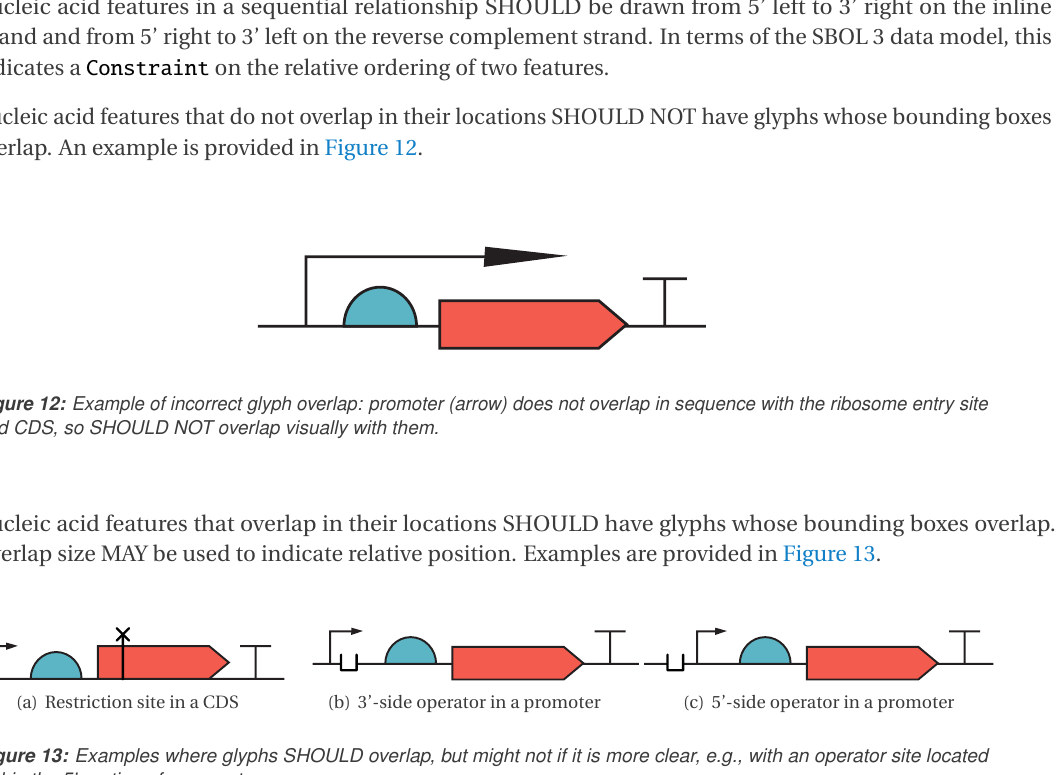
Figure 13: Examples where glyphs SHOULD overlap, but might not if it is more clear, e.g., with an operator site located within the 5’ portion of a promoter.